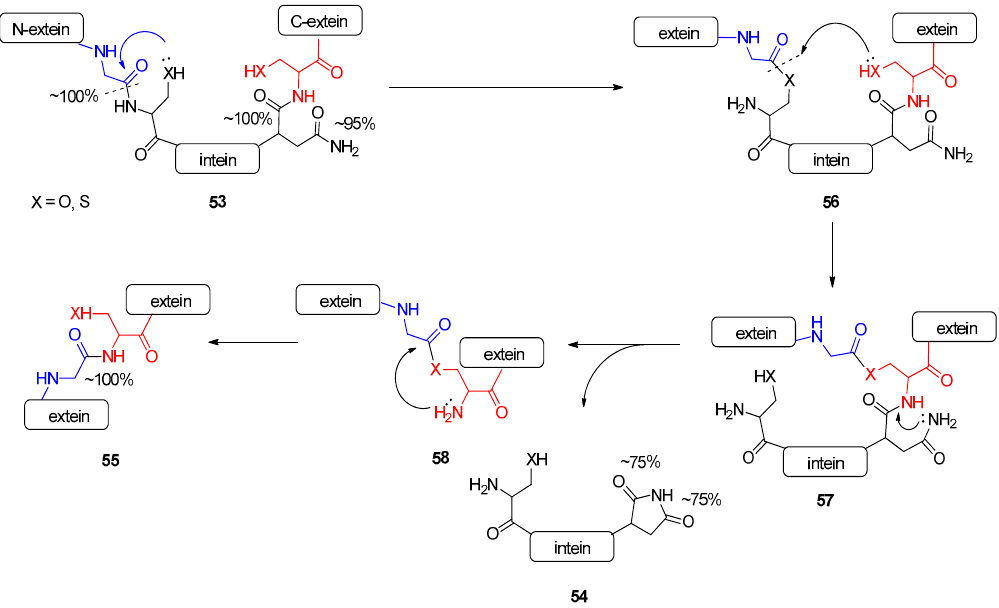
Figure 19. The mechanism of action of protein splicing as a special type of transamidation reaction.